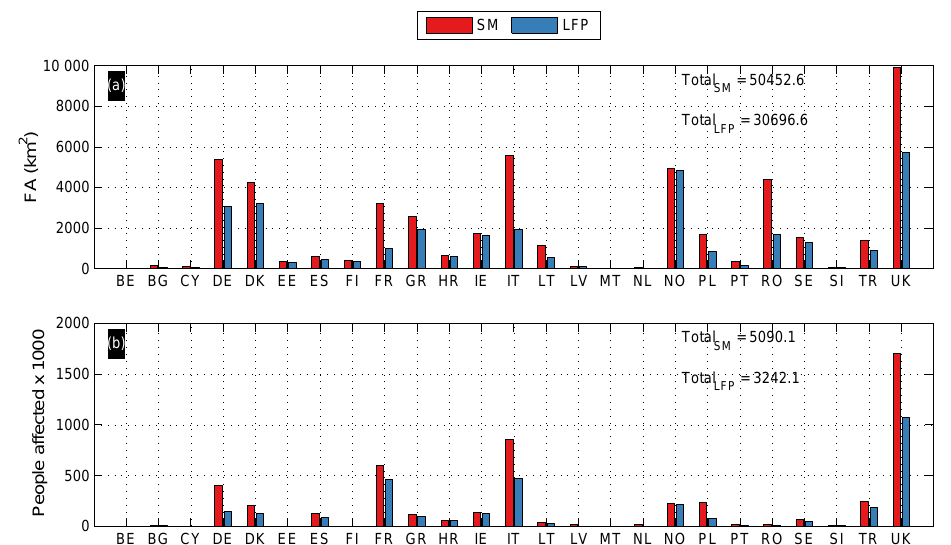
Figure 8. Estimated values of the country level FA (a) and thousands of people affected (b) for the present-day 100-year event; comparisons between the results using the static approach and LISFLOOD-FP.